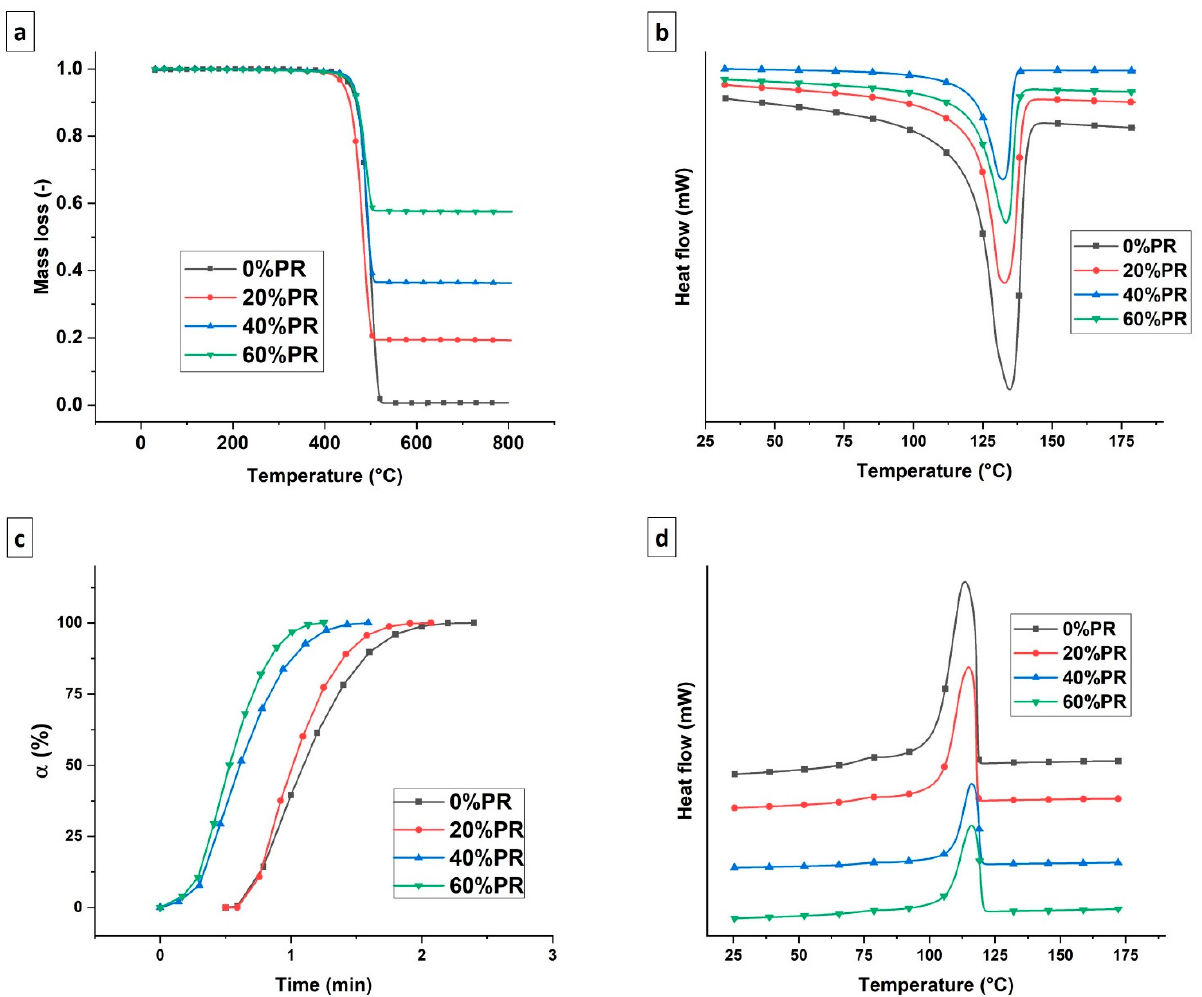
Figure 4. ( a ) Thermogravimetric analysis thermogram. ( b ) Differential scanning calorimetric second heating thermogram. ( c ) Relative crystallinity as a function of time. ( d ) Differential scanning calorimetric second cooling thermogram. Table 4. Thermal properties obtained by differential scanning calorimetric analysis.